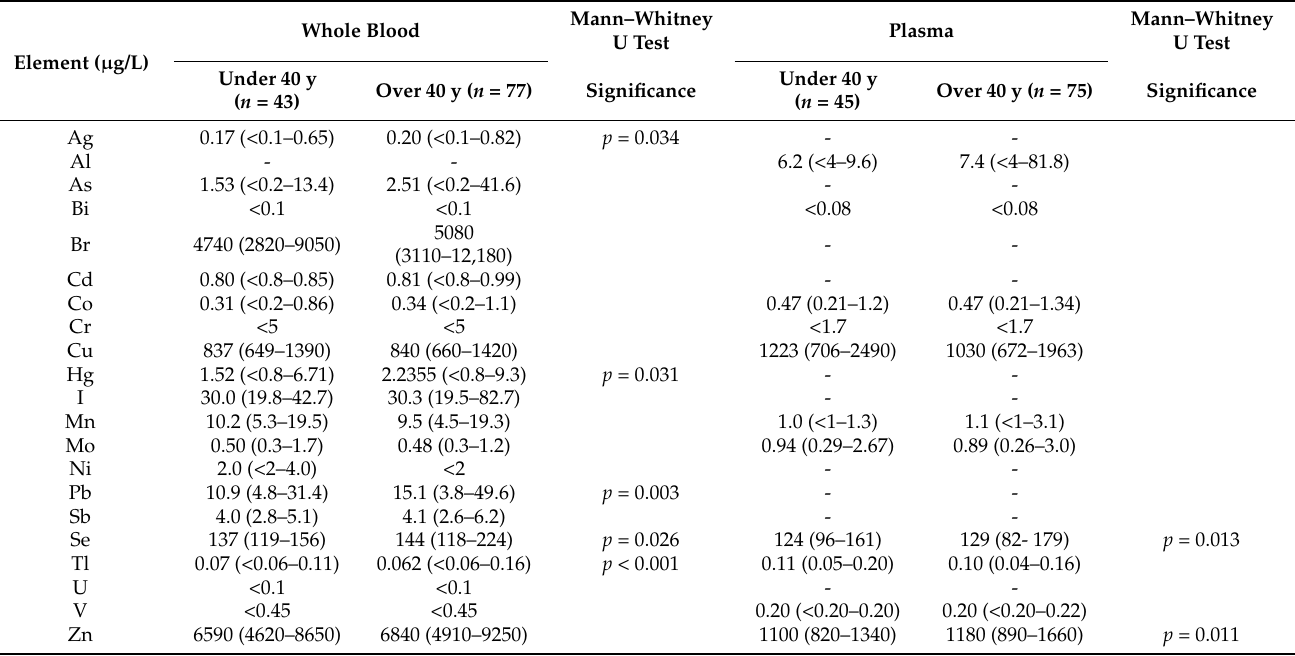
Table 7. Trace element levels in blood for under and over 40 years old.